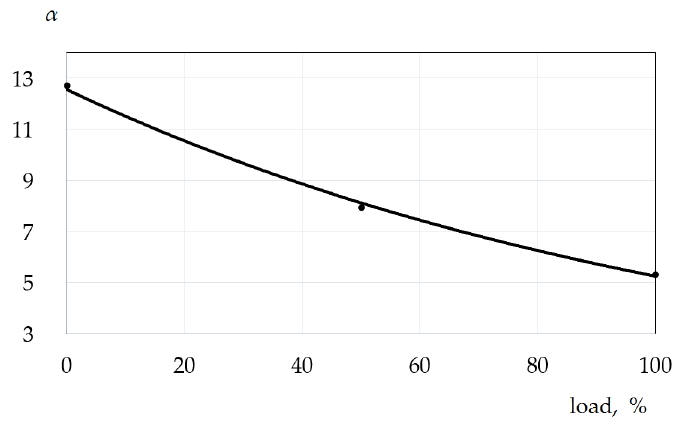
Figure 3. Dependence of the excess air ratio behind the combustion chamber on the load value.